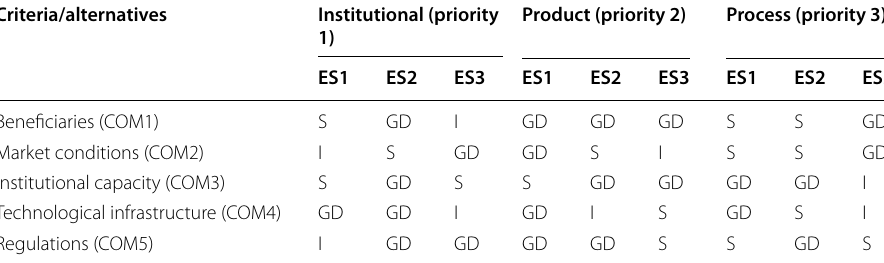
Table 23 LEs for the phase 4 of QFD Criteria/alternatives